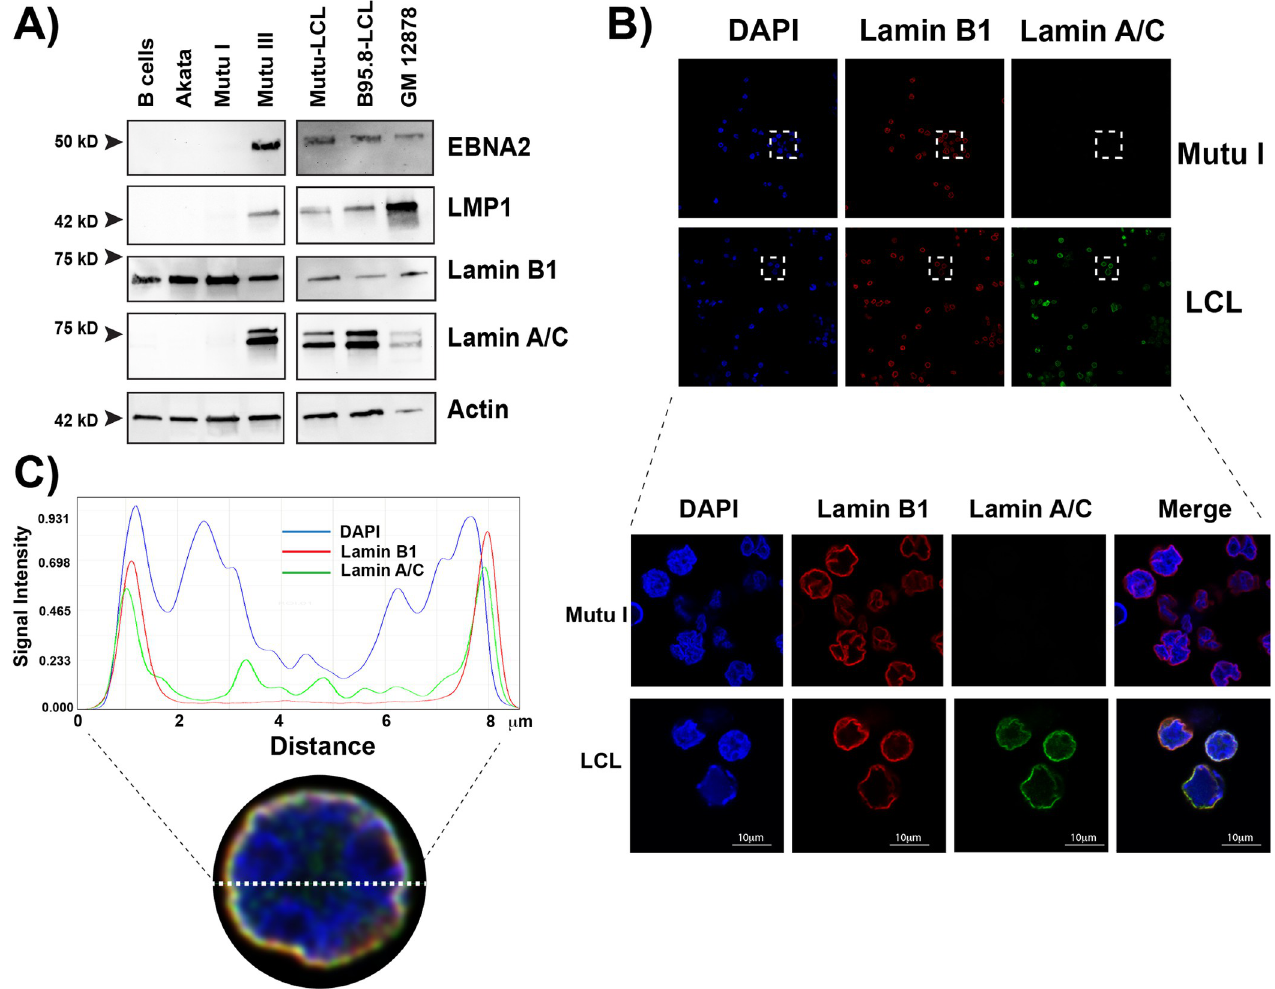
Fig 1. Type I and Type III EBV+ cells express different components of the nuclear lamina. A) Western blot for key EBV proteins (EBNA2, LMP1) and nuclear lamina components (lamin B1 and A/C) in EBV-negative cell lines (B cells, Akata) and EBV-positive cell lines that express the type I (Mutu I) or the type III (Mutu III, Mutu-LCL, B95.8-LCK, GM12878) latency program. EBV actin was used as a loading control. Images are representative of at least three independent experiments. B) Top: Confocal microscopy analysis of EBV+ Mutu I and LCL cells stained with anti-Lamin B1 and anti-Lamin A/C antibodies and DAPI. The images show that lamin A/C is differentially expressed, depending on the presence of EBV and its latency state. Bottom: Higher magnifications of the boxed areas showing colocalization of the lamin proteins at the nuclear periphery. C) Representative quality analysis of the fluorescence intensity in LCL cell nuclei immunostained as described above. The fluorescence intensity was measured along the dotted white line (x-axis) using a Leica software analysis.